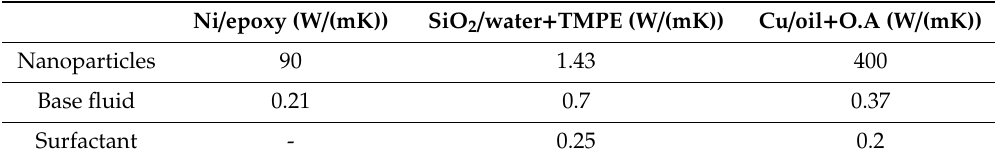
Figure 16. Comparison of experimental results, extracted from [45] (black squares) and simulation results, without the surfactant (blue dots) and with the surfactant (red dots). Table 2. Thermal conductivity of the component materials